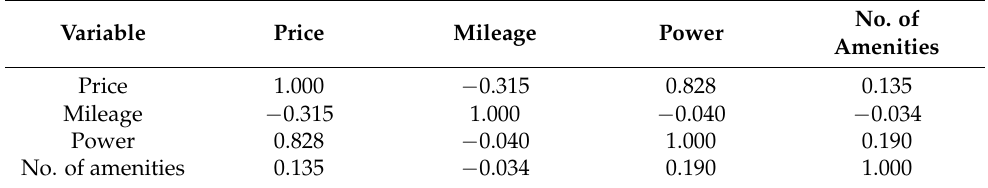
Table 2. Correlation between the dependent variable and independent, quantitative variables.